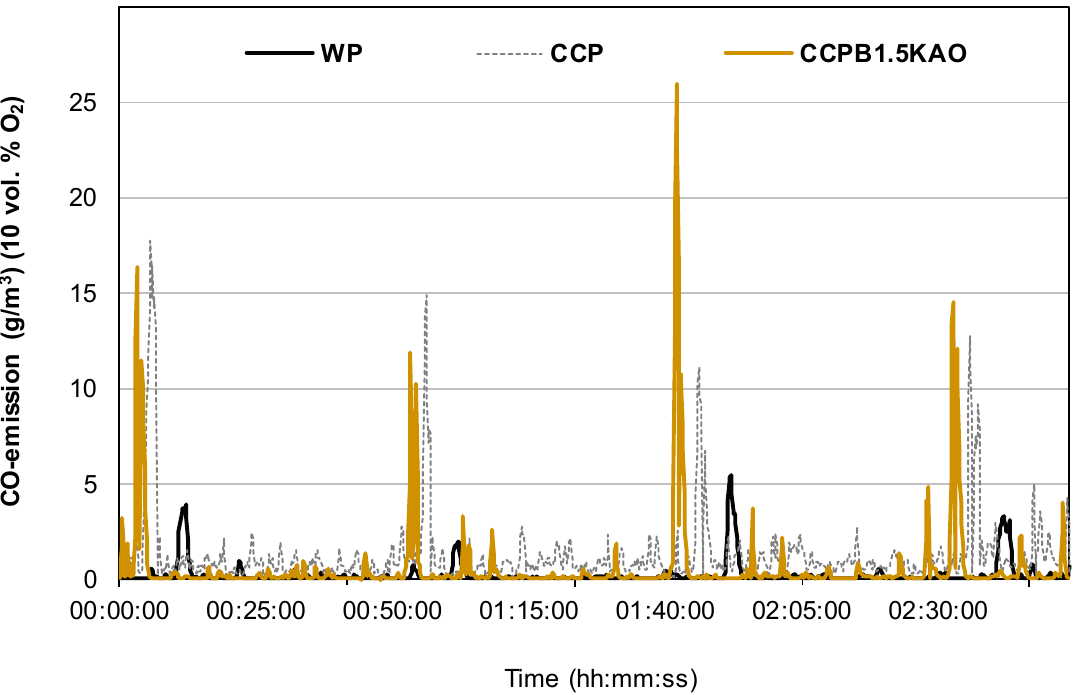
replace approximately 75 wt. % wood pellets in the fuel blends, reducing the amount of wood resources required to achieve CO-emission reduction. Figure 4. Carbon monoxide (CO-) and total particulate matter (TPM-) emissions (for experimental list see Table 2).